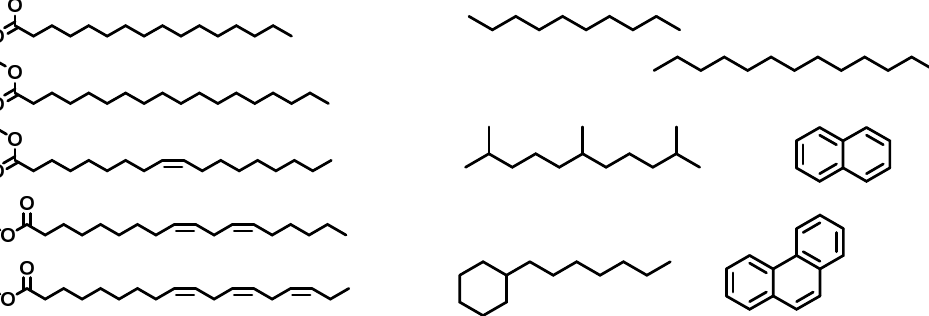
Figure 1. Formulas of C16:0, C18:0, C18:1, C18:2, C18:3, from top to bottom ( left side ) and a selection of diesel components ( right side